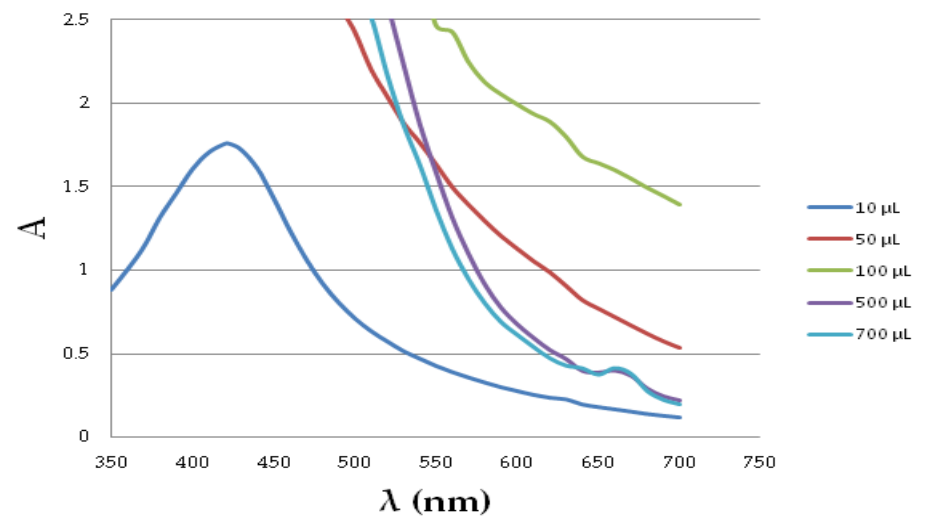
Figure 2. Spectra measured after 30 min in dark place of SNP solution mixed with different volumes of Camellia sinensis extract (10, 50, 100, 500, 700 µL).